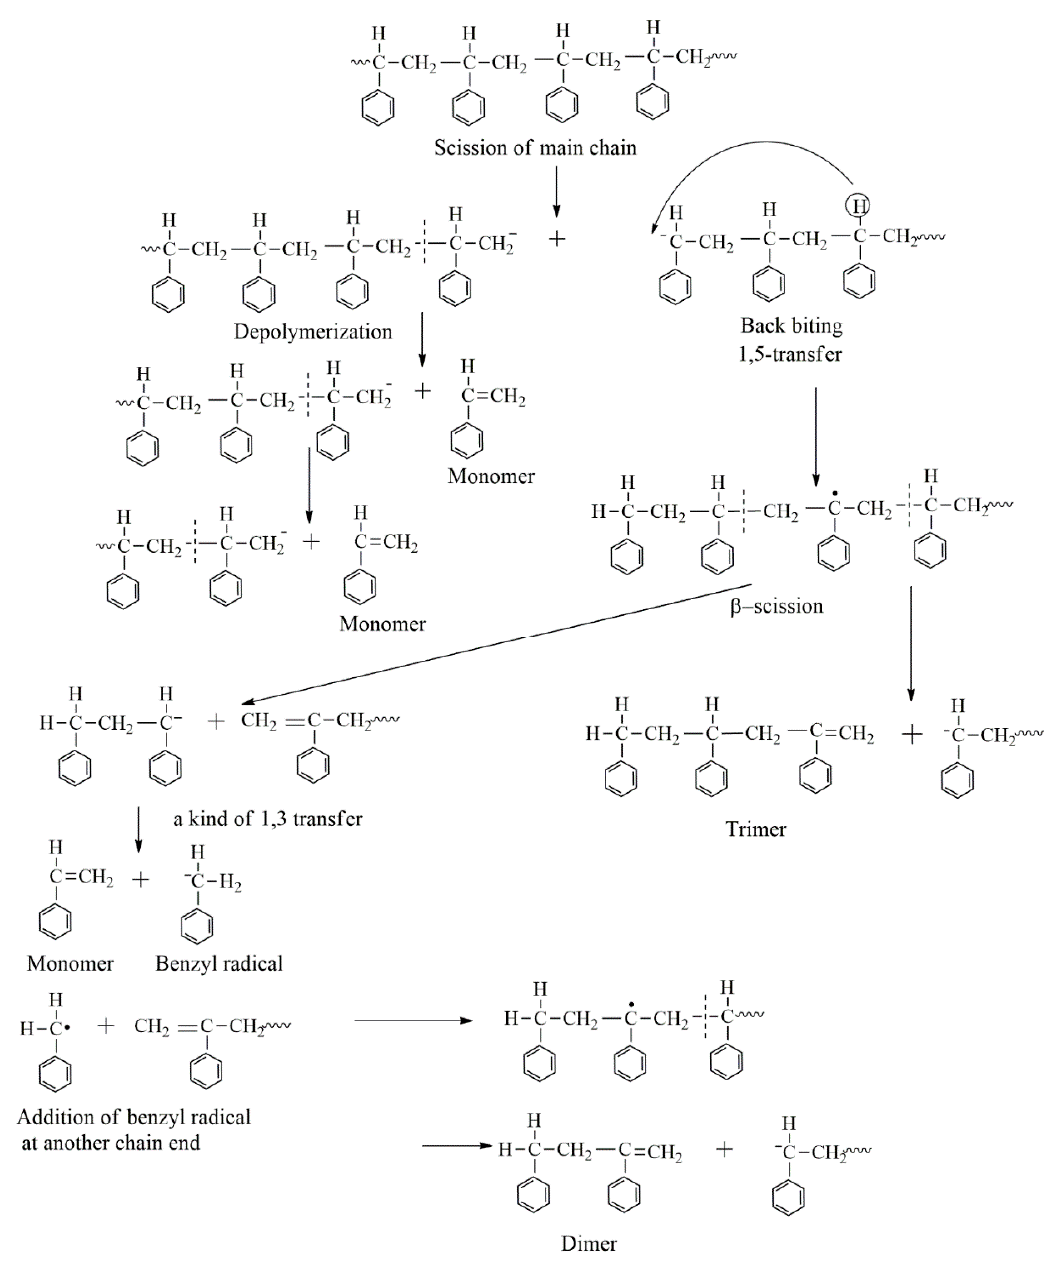
Figure 4. Reaction mechanism for the noncatalytic pyrolysis of polystyrene polymers [31]. (Adapted with permission from Ref. [31], 2000, John Wiley and Sons)